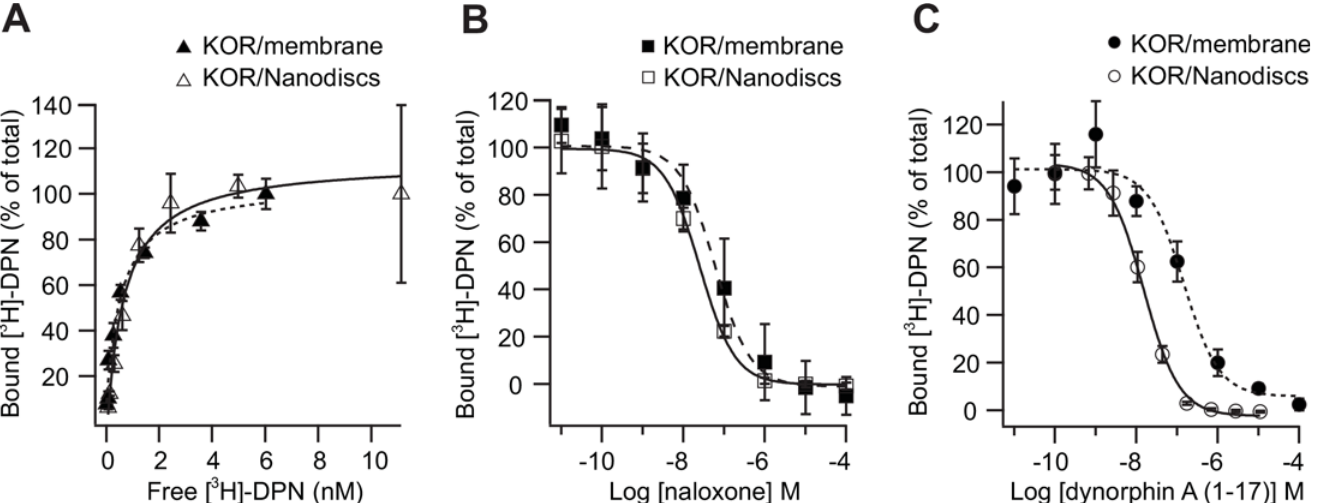
Fig 4. Pharmacology of KOR in isolated P . pastoris membrane and when reconstituted in Nanodiscs. A) Saturation binding assay of [ 3 H]-DPN binding to KOR in membrane (black triangles) or KOR reconstituted in Nanodiscs (open triangles). From the specific binding the affinity constant, K D , of [ 3 H]-DPN binding to KOR was calculated by fitting to a one-site binding model (see Table 2) B) Competition binding experiments with KOR antagonist naloxone and C) KOR agonist dynorphin A (1 – 17). Increasing concentrations of ligand competed the binding of 0.8 nM [ 3 H]-DPN binding to KOR in P . pastoris cell membrane (black marks) or reconstituted in Nanodiscs (open marks). The calculated binding constants ( K i ) are shown in Table 2. Data shown are representative experiments of specific binding normalized to initial binding of [ 3 H]-DPN binding to KOR. Data points are shown with standard deviation of triplicate measurements in one assay. All binding experiments were repeated at least three times.